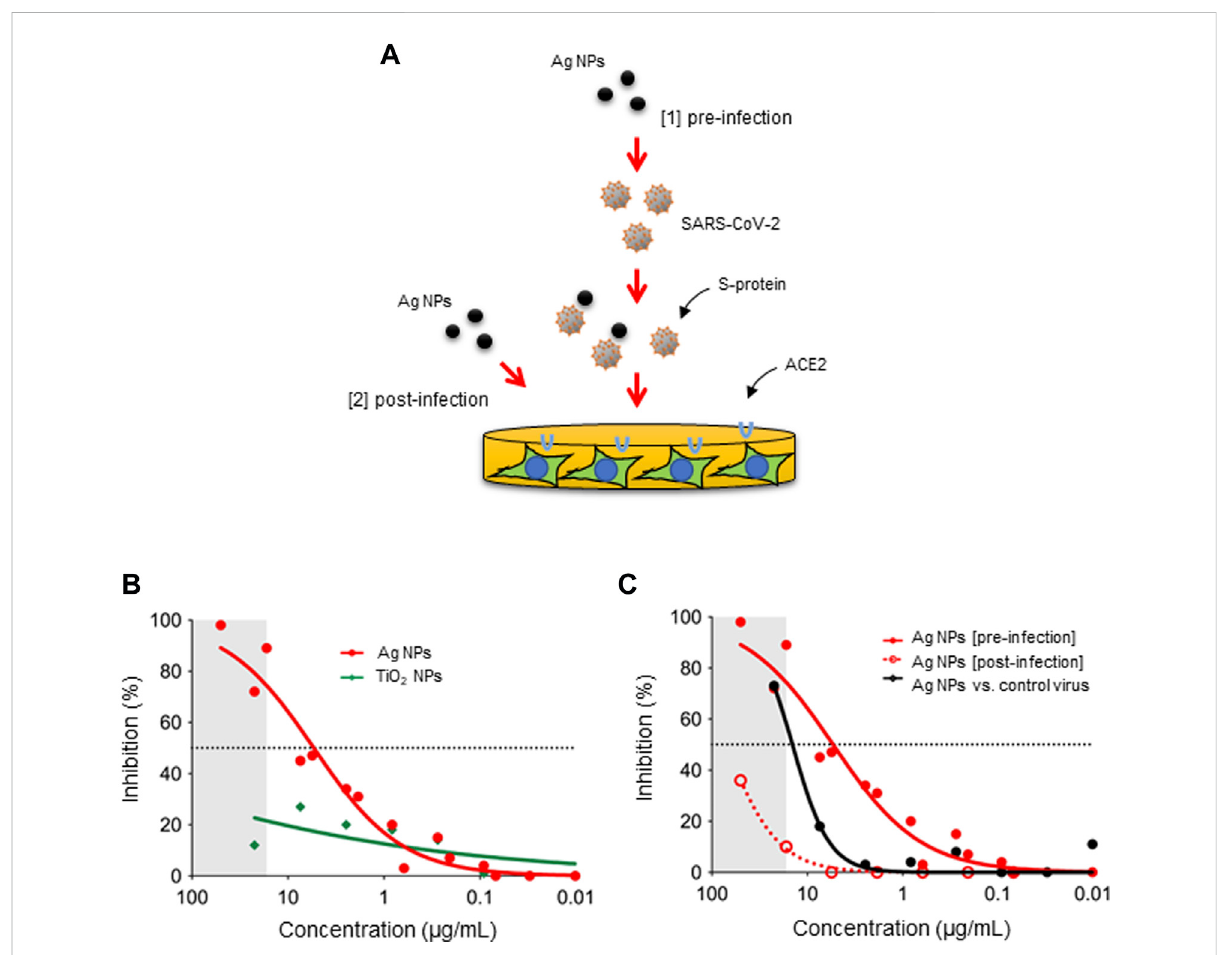
FIGURE 1 AgNPsneutralizevirusespseudotypedwiththeS-proteinofSARS-CoV-2. (A) Theschematic fi gureshowsthetwodifferentapproachesapplied inthepresentstudy,i.e.,pre-incubation oftheviruswiththeNPs(pre-infection)andadditionoftheNPstothecellsafterthecellshavebeeninfected (post-infection). The pseudovirus neutralization assay was performed using ACE2-expressing HEK293T cells. (B) Inhibition of pseudovirus infection after pre-incubation with Ag-B NPs versus TiO 2 NPs for 1 h. (C) Comparison of inhibition potential of Ag-B NPs under pre-infection and post- infection conditions. The dotted line represents the EC 50 value (8.0 μ g/ml). Additionally, Ag-B NPs were pre-incubated with the non-pseudotyped (control) virus. The grey area denotes concentrations at which reduced cell numbers were seen under the light microscope following exposure to pseudotyped virus pre-incubated with Ag-B